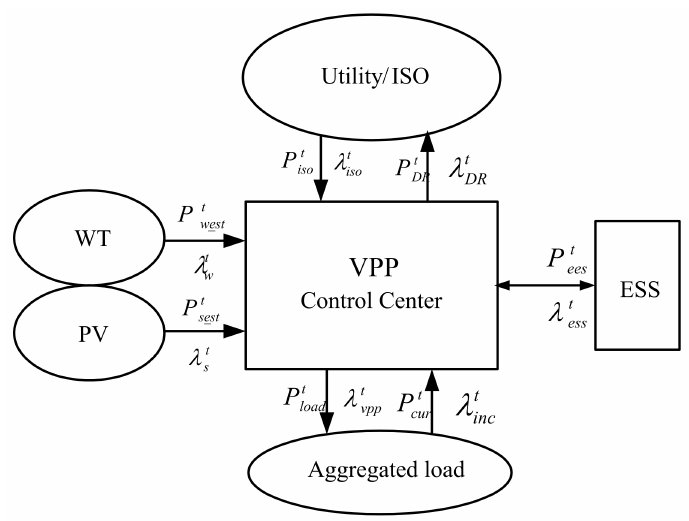
Figure 1. The VPP’s